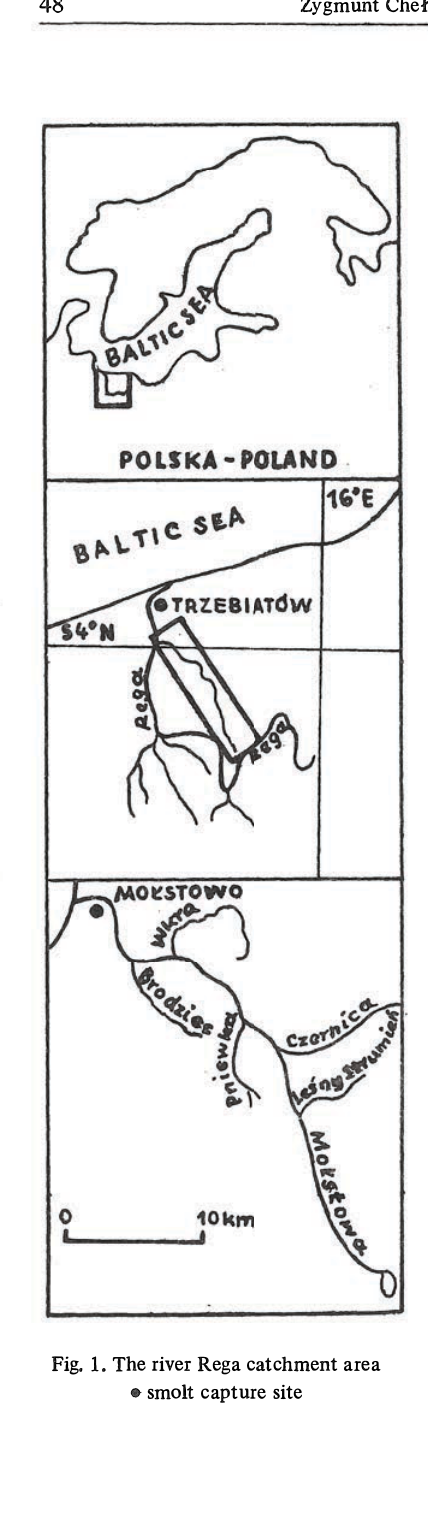
Fig, 1. The river Rega catchment